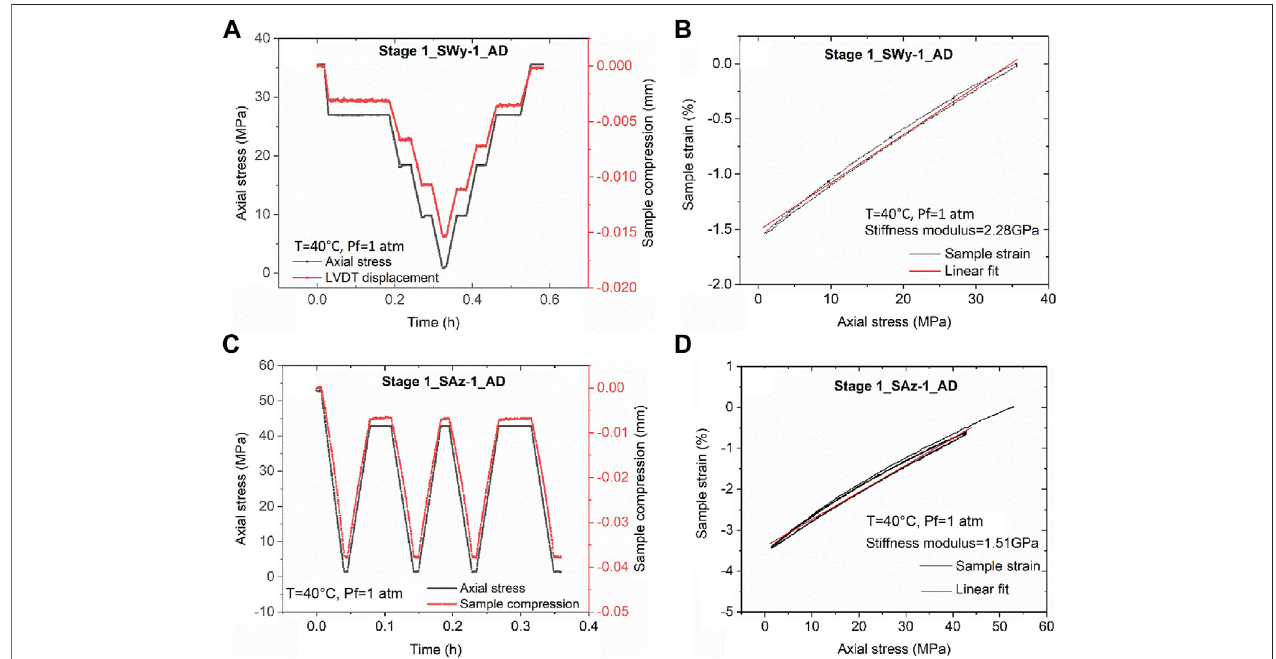
FIGURE 2 | Data obtained in rapid Stage 1 stress cycling runs performed to assess the elastic properties of the AD samples before pore fl uid addition. (A) Stress path employed in a rapid unloading/loading cycle applied to the AD Na-SWy-1 sample, plus concurrent change in sample thickness. (B) Corresponding sample strain versus applied axial stress data for the AD Na-SWy-1 sample. Note the largely reversible elastic behaviour and constrained stiffness modulus of 2.28 GPa. (C) Stress path andconcurrentchangeinsamplethicknessfortheADSAz-1sampleduringarapidStage1unloading/loadingcycle. (D) Correspondingsamplestrainversus applied axial stress data for the AD Ca-SAz-1, giving a constrained stiffness modulus of 1.51 GPa.